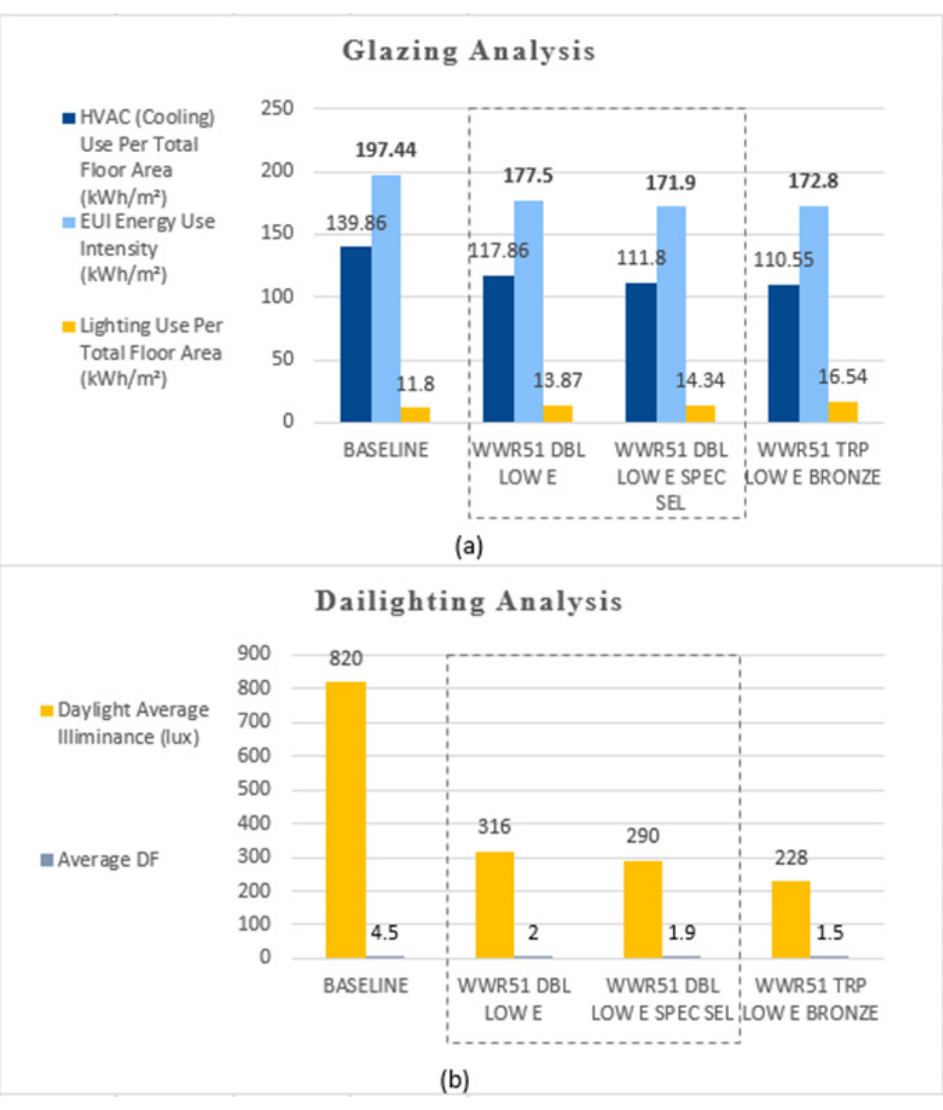
Figure 8. Effect of glazing type on building energy use ( a ) and daylight illuminance ( b ) (optimum performance highlighted in the dotted box).